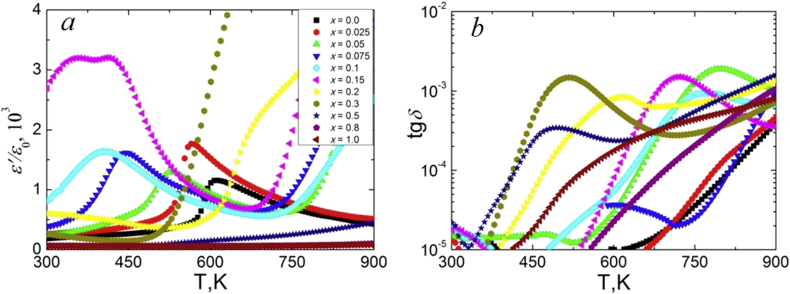
Temperature dependences of ε'/ε0 (a) and tgδ (b) at 100 kHz for NSN solid solutions.